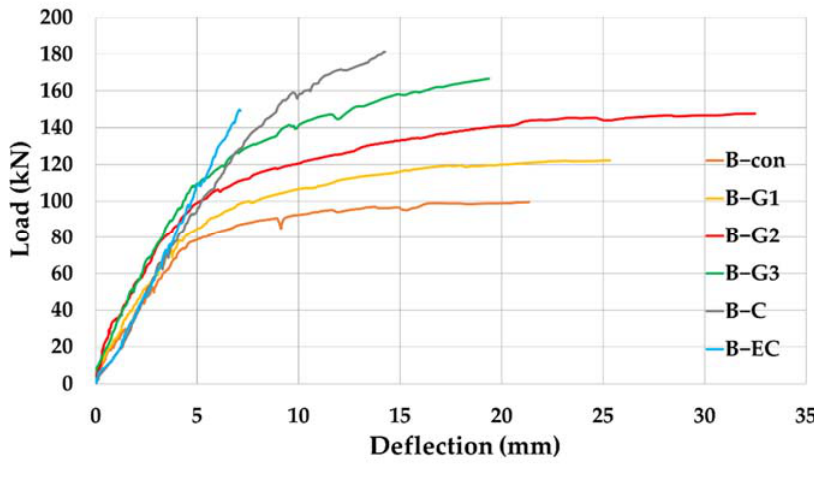
Figure 10. Mid-span deflection diagram for different strengthening variants.